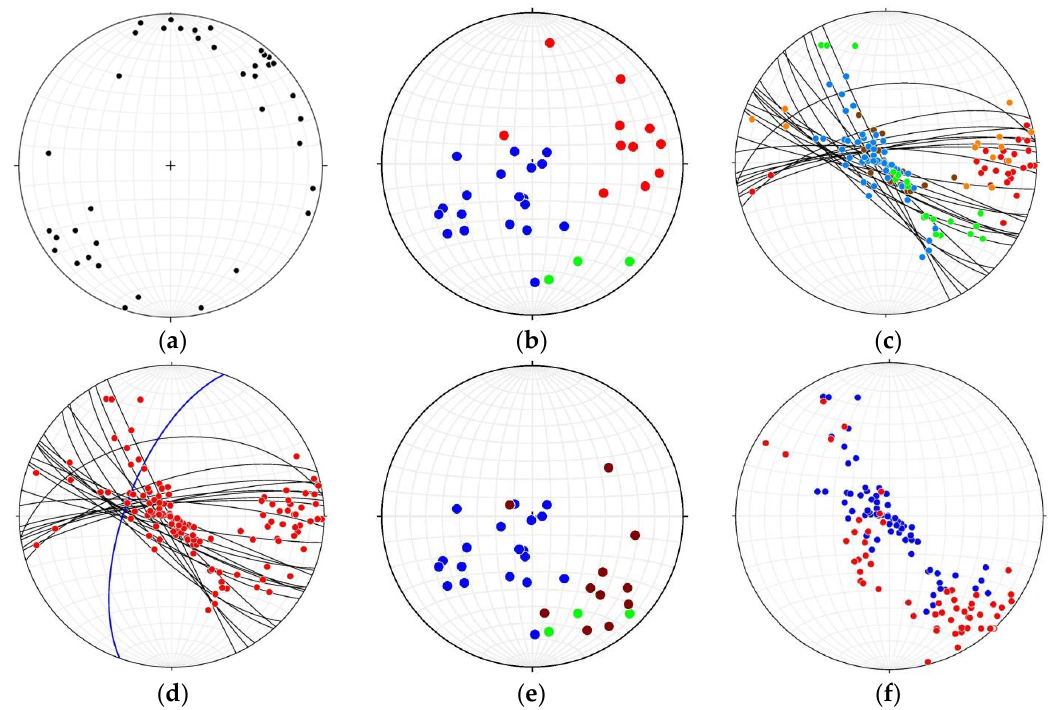
Figure 6. ( a ) Orientation of poles to the intrusive diorite-sediment contacts, as observed in the drill core and the field ( N = 38); ( b ) Orientation of F 2 fold axes in Kukuluma and Matandani pits ( N = 33). Colour coding: red = southern ramp in the Kukuluma pit; blue = southwest side in the Matandani pit; green = northeast side in the Matandani pit; ( c ) Orientation of S 3 fold axial planes (great circles) and F 3 fold axes in the Kukuluma and Matandani pits. Colour coding: red = southern ramp in Kukuluma pit; orange = western ramp in Kukuluma pit; brown = northwest wall in Kukuluma pit; blue = southwest side in Matandani pit; green = northeast side in Matandani pit; ( d ) Orientation of S 3 fold axial planes (great circles) and F 3 fold axes (red dots) in the Kukuluma and Matandani pits. S 3 and F 3 are distributed in two clusters in either limb of D 4 folds. S 4 (blue great circle) equals the plane bisecting the obtuse angle = 290/65; ( e ) Orientation of F 2 fold axes in Kukuluma and Matandani pits, in which the Kukuluma axes have been rotated clockwise by 50 degrees around an axes of 287/65, to remove the effects of D 4 open folding. Colour coding: brown = rotated orientations along the southern ramp in the Kukuluma pit; blue = southwest side in the Matandani pit; green = northeast side in the Matandani pit; ( f ) Orientation of F 3 fold axes in Kukuluma and Matandani pits, in which the Kukuluma axes have been rotated clockwise by 50 degrees around an axes of 287/65, to remove the effects of D 4 open folding. Colour coding: red = rotated F 3 orientations in Kukuluma pit; blue = F 3 orientations in Matandani pit.